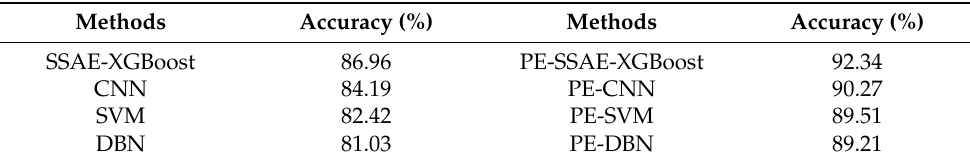
Table 5. Comparison of diagnosis accuracy with unknown